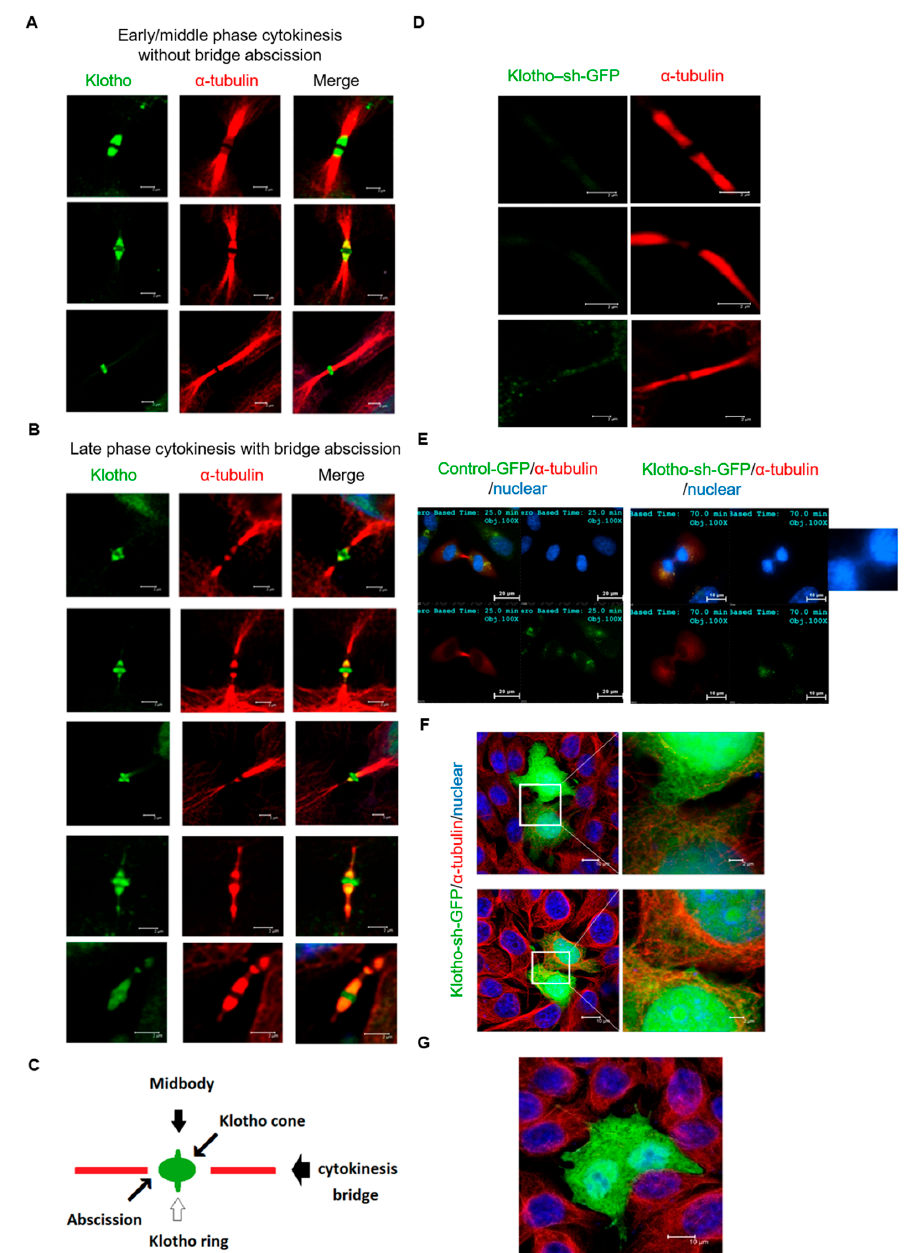
Figure 5. Klotho depletion impairs cytokinesis bridge abscission. The intrinsic Klotho of cultured HeLa cells was analyzed by immunofluorescence with Klotho N-terminal specific antibody for ( A ) and ( B ). ( A ) Cytokinesis bridge structures of early and middle stages of cytokinesis. ( B ) Cytokinesis bridge structures of late stages of cytokinesis. ( C ) Illustration of the space association between the Klotho ring and cone, and cytokinesis bridge abscission. Cultured HeLa cells transfected with control-GFP or Klotho-sh-GFP were analyzed by immunofluorescence for ( D – G ). ( D ) Tubulin immunofluorescence staining with HeLa cells transfected with Klotho-sh-GFP. The representative images of the bridge of late cytokinesis are shown. ( E ) Live cell images of HeLa cells at late cytokinesis stage. The white arrow box indicates the delayed chromatin separation in Klotho depleted cells. ( F ) Representative image of Klotho depleted HeLa cells with connected cytoplasm. ( G ) Representative image of Klotho depleted HeLa cells with multiple nuclei. The ratios of multinucleated cells of wild type and Klotho depleted HeLa cells under the normal growth condition are calculated. The ratios of multinucleated cells are 5% (1 / 20) and 16.7% (3 / 18) for wild type and Klotho depleted cells, respectively (microscopy: ×